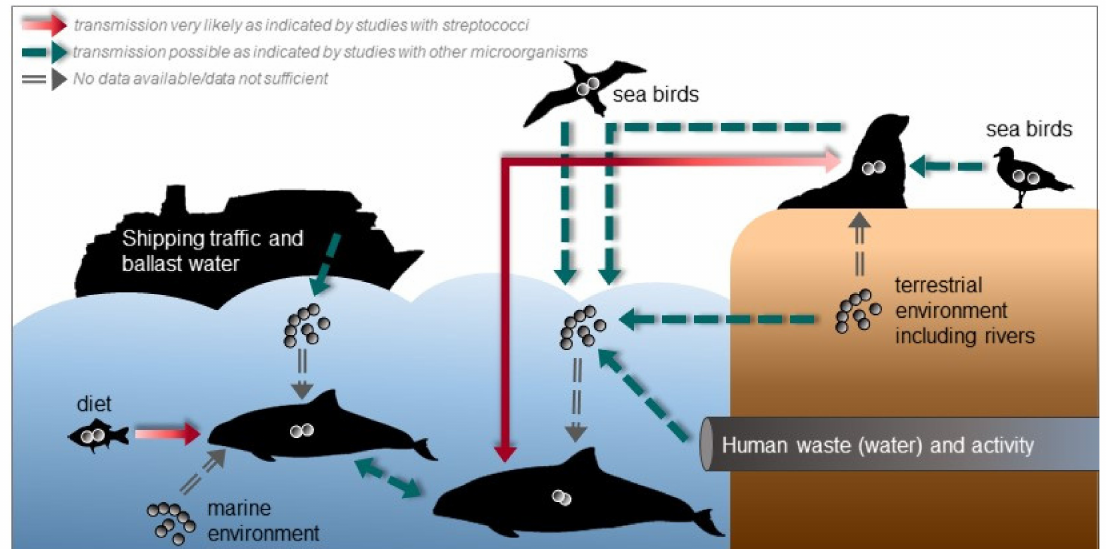
Figure 3. Possible ways how streptococci are introduced into marine environments and how they may be transmitted to and between marine mammals. Most indicated transmission routes are hypothetical based on general microbiological observations. In the other cases, there are studies showing that the transmission route is very likely or even confirmed. Hence, this figure displays scientific gaps that has still to be filled and where data are